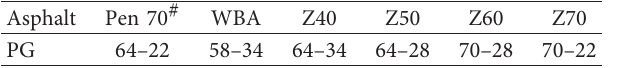
Table 5: PG classification.